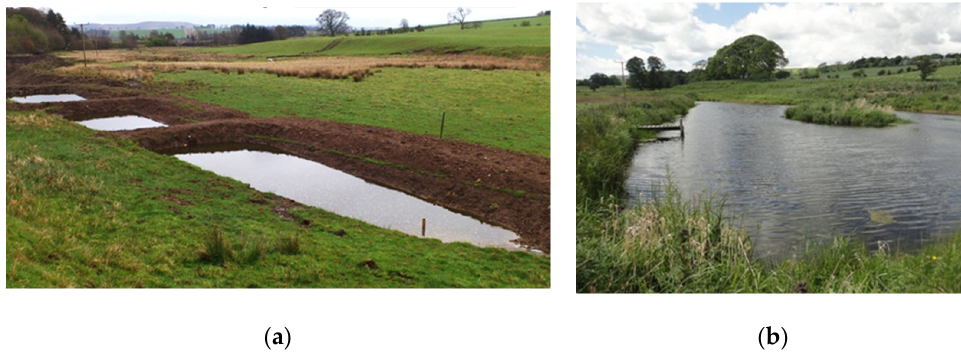
Figure 8. ( a ) In Netherton Burn (Northumberland), a ditch has been modified to create sediment traps [51] and ( b ) a permanent pond with 1m of available flood storage. This RAF protects a larger flood storage pond immediately downstream which provided the main RAF storage requirements.